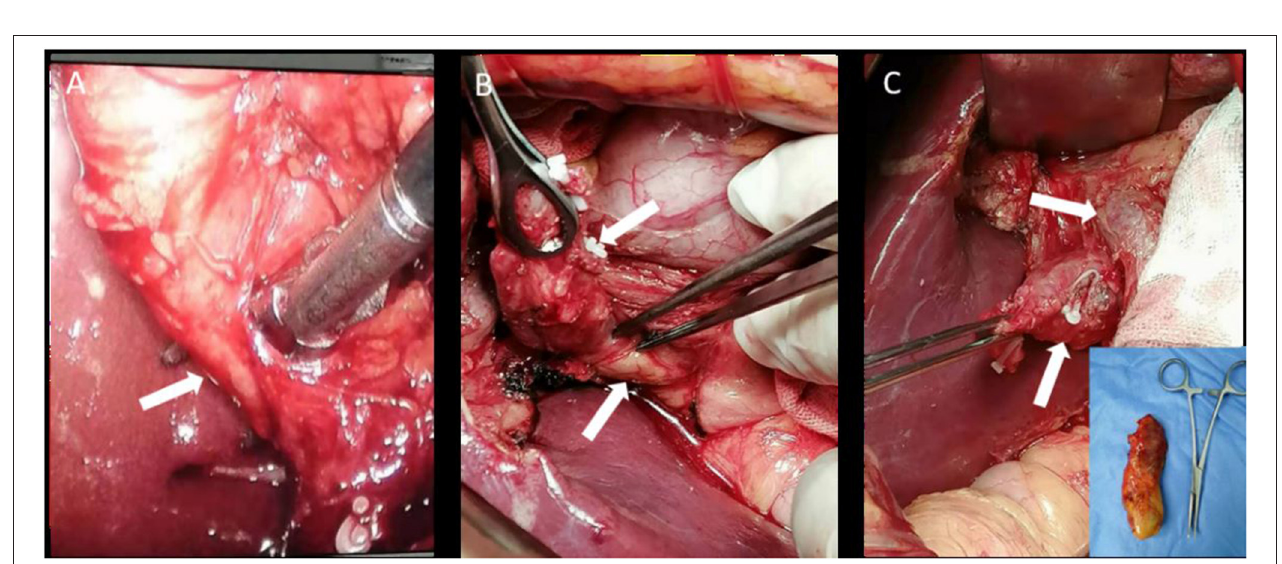
FIGURE 2 | Intraoperative photographs. (A) Cystic duct isolation with an ultrasonic knife (white arrow); (B) CDC and the pancreatic head (white arrows); and (C) CDC and the common bile duct (white arrows). The embedded image showed the excised gallbladder specimen.